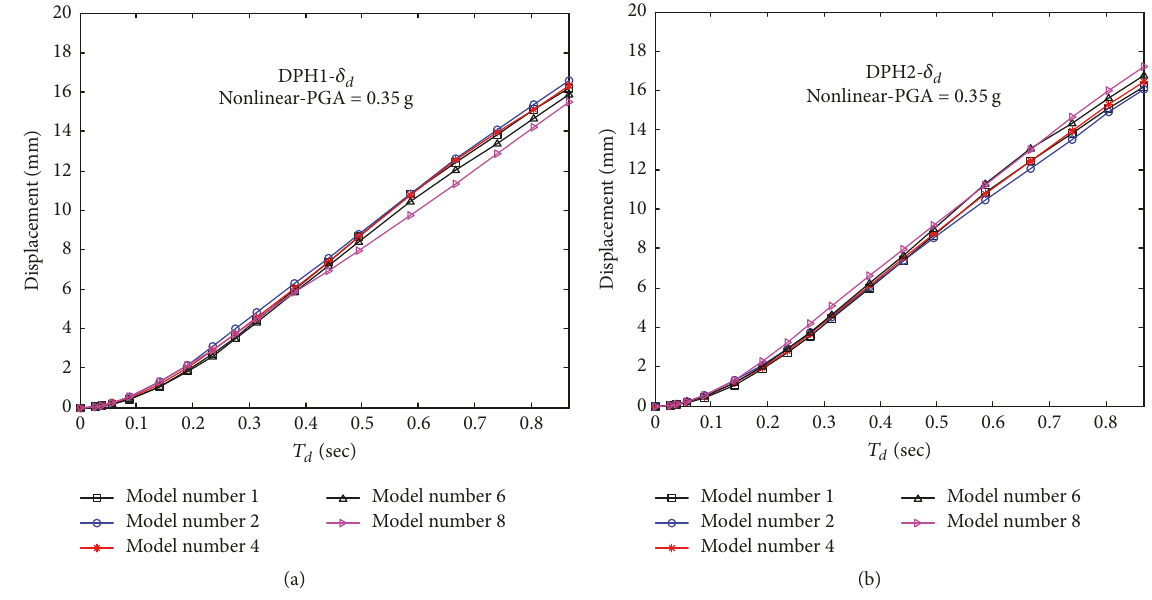
Figure 10: Bending-dominant deformation of diaphragms in DBE earthquakes: (a) DPH1 and (b) DPH2.